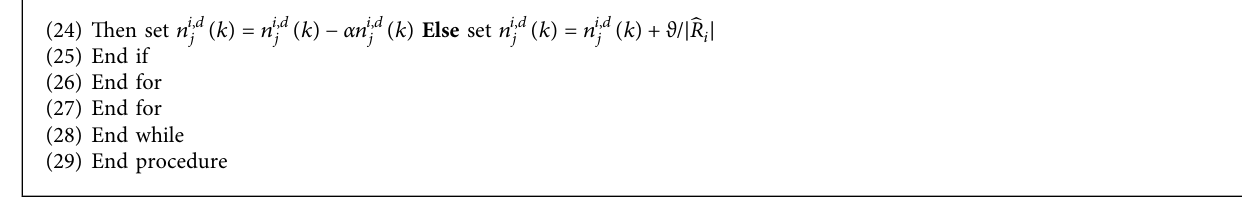
A LGORITHM 5 : Algorithm for lower-level model.